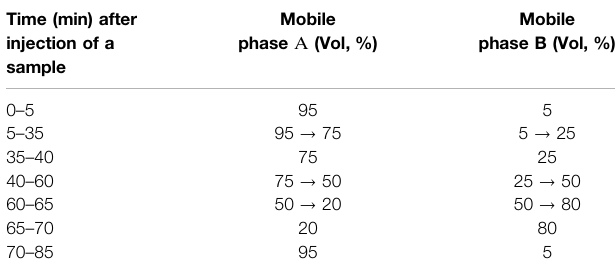
TABLE 1 | Gradient of the mobile phases in HPLC analysis (Shanaida et al., 2018a). Time (min) after injection of